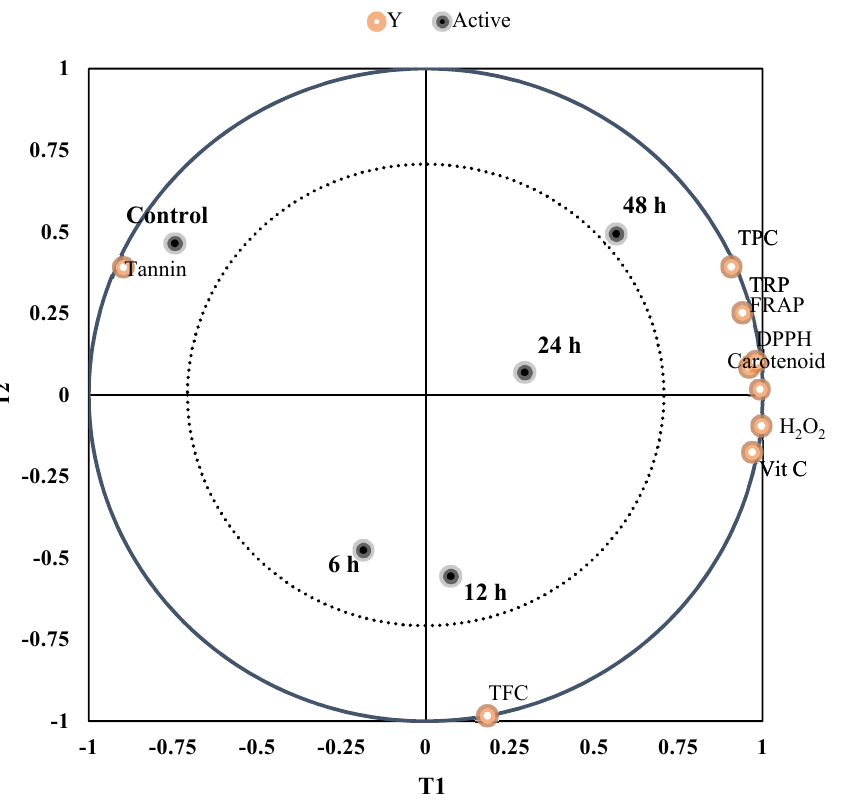
Figure 2. Partial least squares regression analysis (PLS) of fermented “Nabag” ( Ziziphus spina-christi L.) seeds, phytochemical compound contents (TPC, TFC, tannin, vitamin C, and total carotenoid), and antioxidant activities (DPPH, FRAP, TRP, and H 2 O 2 ).